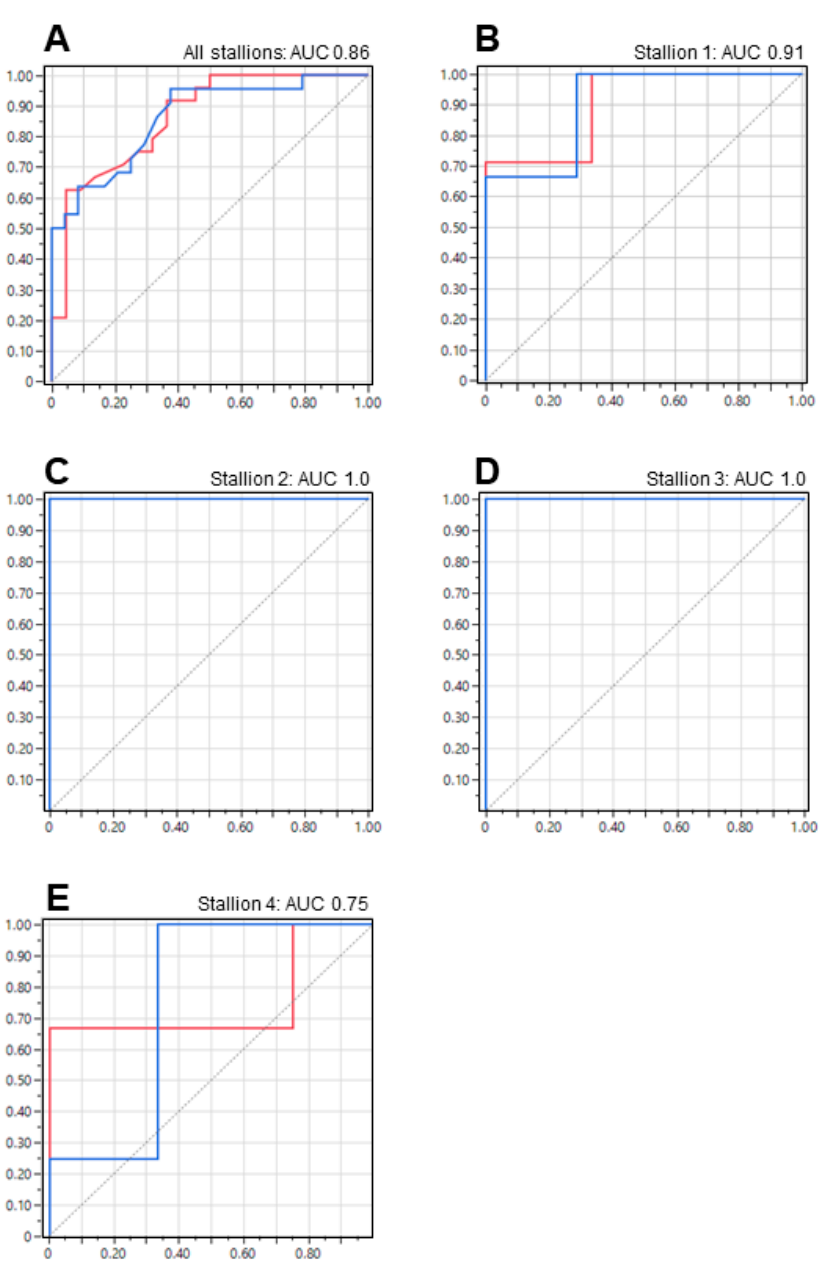
Figure 5. Receiver operating characteristic (ROC) curves were used to predict pregnancy based on stallion spermatozoa analyzed before chilling (pre-chill), with the aim of achieving an Area Under the Curve (AUC) value as close to 1.0 as possible. ( A ) Inclusion of all stallions resulted in a high AUC value of 0.86. When the analysis was optimized for individual stallions. AUC values in excess of 0.91 were routinely obtained ( B – D ), except for 1 case ( E ) which returned an AUC of 0.75.